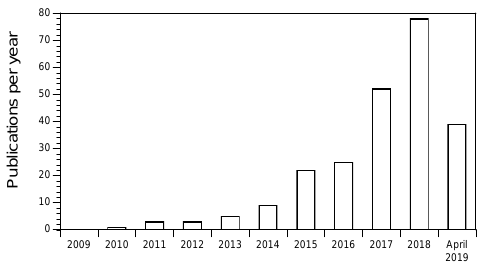
Figure 2. Number of publications detailing the quantification and characterisation of microplastics in freshwaters and estuaries per year. For 2019, only data up to April are included in this review.